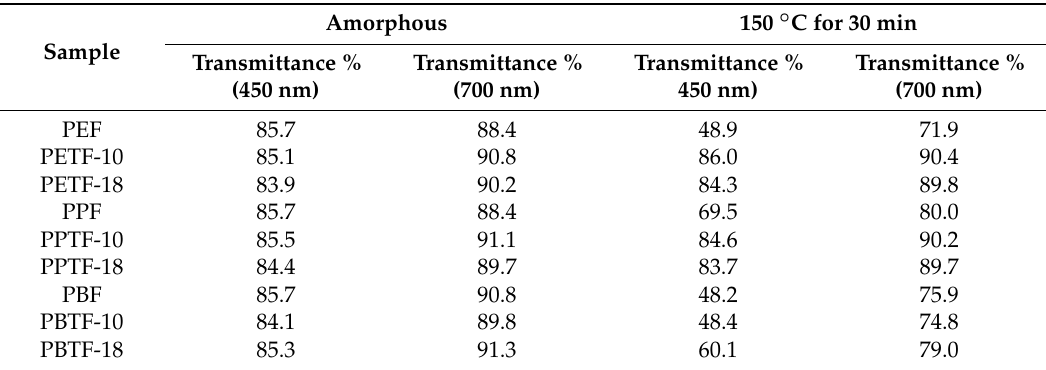
Table 4. Transmittance of PEF, PPF, PBF, and the copolyesters modified by CBDO at different wavelength (the deviation is about ± 1% for all the reported data here).